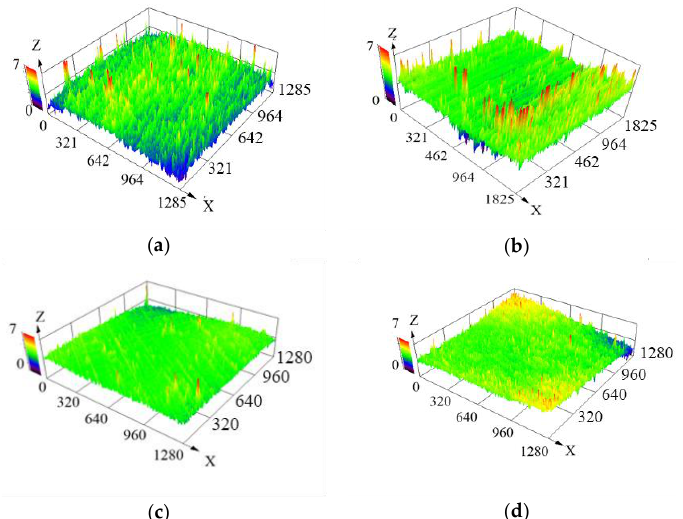
Figure 9. 3D white-light interfering profiles of the steel plate and QBe2 beryllium bronze pins: ( a ) on the initial surface and ( b ) on the worn surface of 38CrMoAlA steel plate, as well as ( c ) on the initial surface and ( d ) the worn surface of QBe2 beryllium bronze pin.